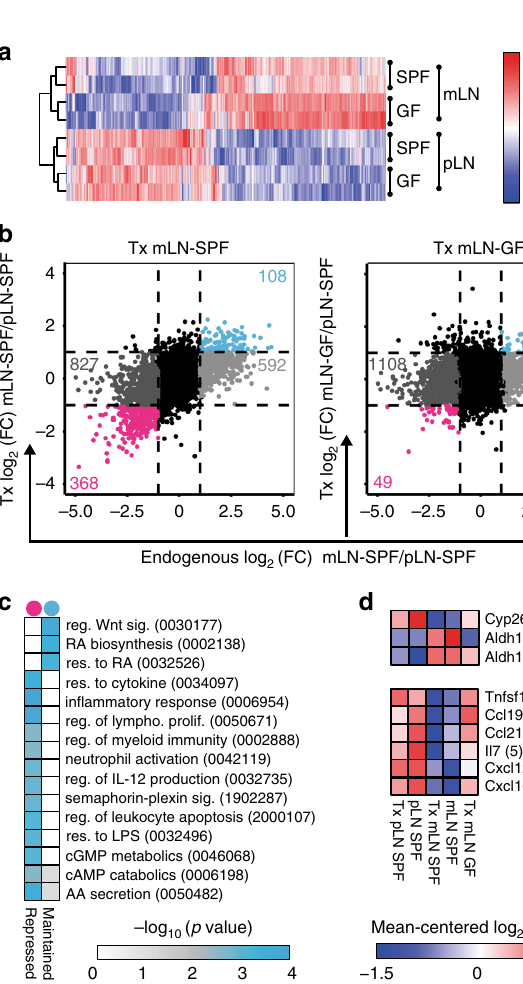
Fig. 3 Location-speci fi c transcriptional signatures of mLN FSCs are imprinted by microbiota. a CD45 − Ter119 − CD31 − gp38 + FSCs were isolated from mLNs and pLNs of GF or SPF mice, and RNA-seq and subsequent analysis was performed. DEGs were identi fi ed in colonization-dependent (SPF vs. GF) and location-dependent (mLNs vs. pLNs) pairwise comparisons (|log 2 (FC)| ≥ 1 and q -value ≤ 0.05). Heatmap represents 1411 DEGs. Mean-centered log 2 (RPKM) values are depicted. Data pooled from two independent experiments. b CD45 − CD24 − CD31 − gp38 + FSCs were isolated from endogenous mLN-SPF and pLN-SPF, transplanted pLN-SPF and mLN-SPF or transplanted mLN-GF. RNA-seq L and subsequent analysis was performed. Colored numbers in scatterplots represent DEGs (|log 2 (FC)| ≥ 1 and q -value ≤ 0.05) for the pair-wise comparisons of FSCs. On the x -axis log 2 (FC) of gene expression from FSCs (endogenous LNs) is plotted. (left) On the y -axis log 2 (FC) of gene expression from FSCs from transplanted mLN-SPF vs. pLN-SPF is plotted. (right) On the y -axis log 2 (FC) of gene expression from FSCs from transplanted mLN-GF vs. pLN-SPF is plotted. Data pooled from two to four independent experiments ( n = 3 – 8). c GO analysis of biological processes of genes persistently up-regulated (Maintained, blue dot) or down-regulated (Repressed, pink dot) in FSCs of transplanted mLN-SPF. d Heatmaps of expression of genes involved in RA metabolic process or of soluble mediators within FSCs from indicated groups. Numbers in brackets indicate average log 2 (RPKM) expression of respective genes across all experimental groups. Data pooled from two to four independent experiments ( n = 3 – 8). DEG differentially expressed genes, AA amino acid, FC fold-change, FSC fi broblastic stromal cells, GO gene ontology, RA retinoic acid, reg. regulation, res. response, RPKM reads per kilobase of exon length per million mapped reads, sig.